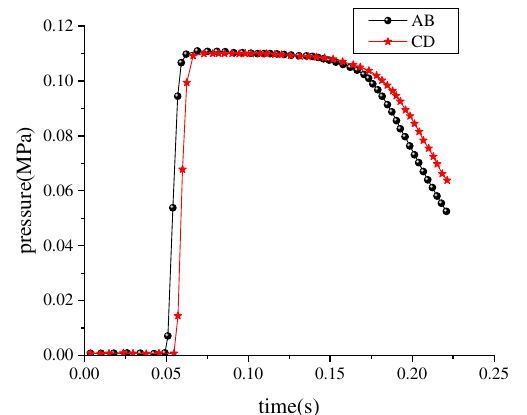
Fig. 4 Gas overpressure variation with time at two different cross sections